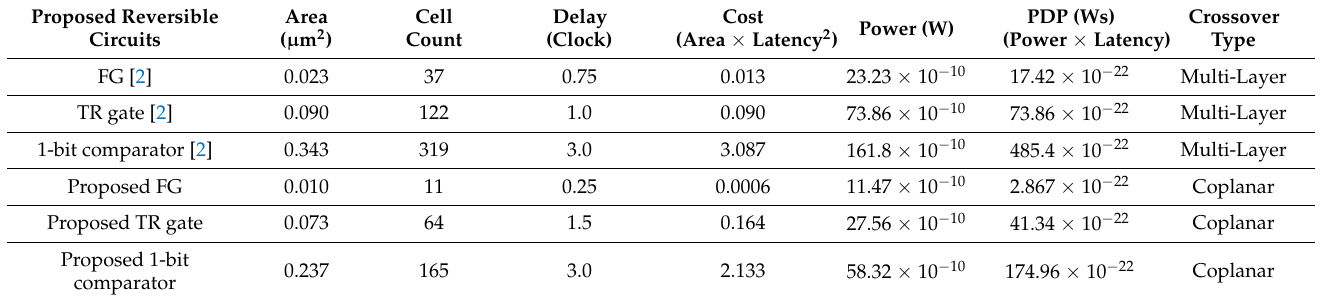
Table 7. Comparison for the proposed QCA reversible circuits of previous